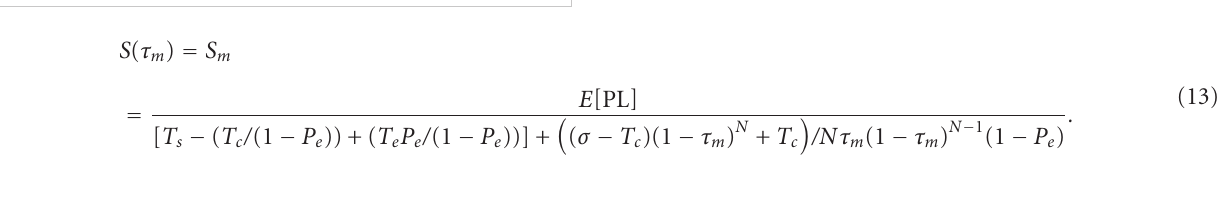
Figure 3: Behavior of λ c in (14) as a function of the packet size E [PL], for two di ff erent values of both N and P respective legends. Other parameters are as follows: W 0 = 32 and m =